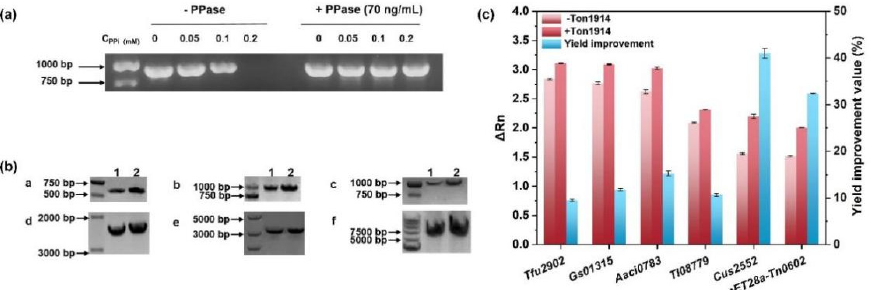
Figure 4. The facilitation of polymerase chain reaction (PCR) by Ton1914. ( a ) The inhibitory effect of PP i on PCR, Gs01315 (954 bp) was used as template, 0, 0.05, 0.1, 0.2 mM PP i was added, and PCR was conducted with or without 70 ng/mL Ton1914, respectively. The PCR system and reaction procedure were performed according to the instructions of the PrimeSTAR ® HS DNA Polymerase reagent kit using conventional PCR equipment. ( b ) Agarose gel electrophoresis results of qPCR with different gene templates, a: Tfu2902 (516 bp), b: Gs01315 (954 bp), c: Aaci0783 (1215 bp), d: Tl08779 (2494 bp), e: Cus2552 (3162 bp), f: pET28a − Tn0602 (6710 bp); 1 was the groups without Ton1914, 2 was the groups with Ton1914; ( c ) The final fluorescence intensity of qPCR for six genes was conducted with and without Ton1914; all gene templates were amplified using the same amplification procedure and underwent 35 qPCR cycles.